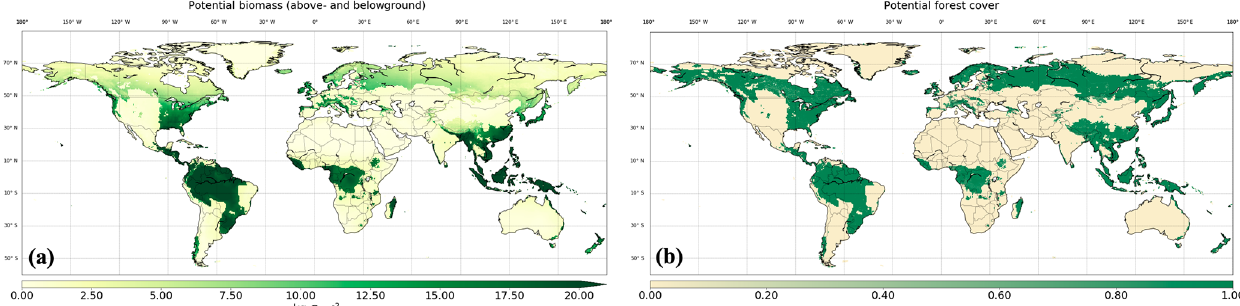
Figure 1. Potential biomass density (a) and potential forest cover (b) in 850 estimated by GLM2 model.